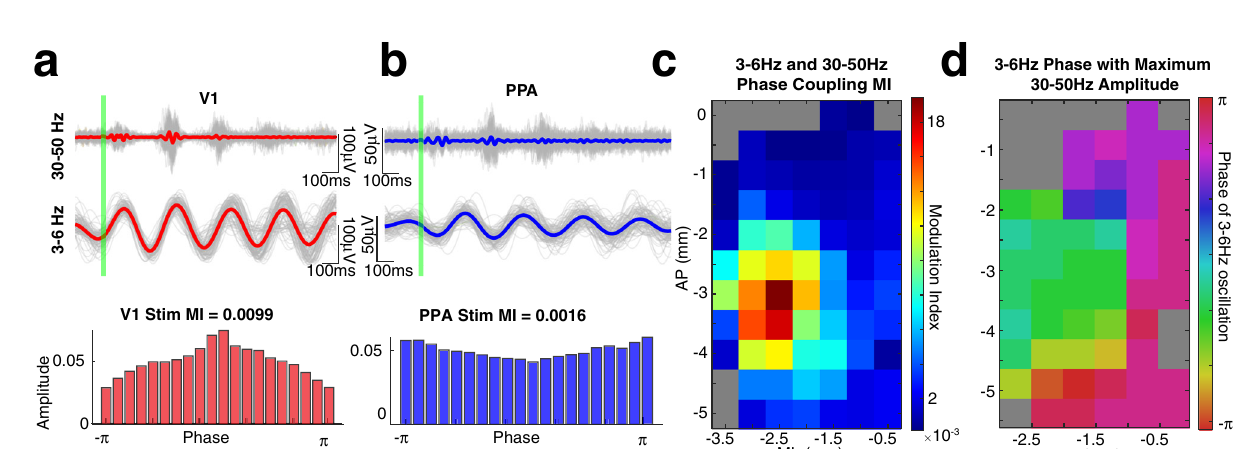
Fig. 6 | The phase of the slow wave modulates the amplitude of the fast wave both within V1 and throughout the cortex. a Top: single trials (gray) and average (red) data fi ltered at 30 – 50Hz over V1 of a representative mouse. Middle: same as above, but for 3 – 6 Hz. Note that fast oscillation bursts occur rhythmically in phase with slow oscillations. Bottom: Amplitude of high fre- quency oscillations at each phase of the low frequency oscillation, averaged over trials. The deviation of this distribution from a uniform distribution is summarized in the modulation index (MI) of 0.00991 ( t = 36.59, p value ~4.9e − 324,one-sidedstudent ’ s t test,df = 99,comparedtotimeshuf fl edsurrogates). b Similar to ( a ) but for an electrode over PPA. The phase-amplitude MI= 0.00155 ( t =30.24, p value ~4.9e − 324, one-sided student ’ s t test, df =99,